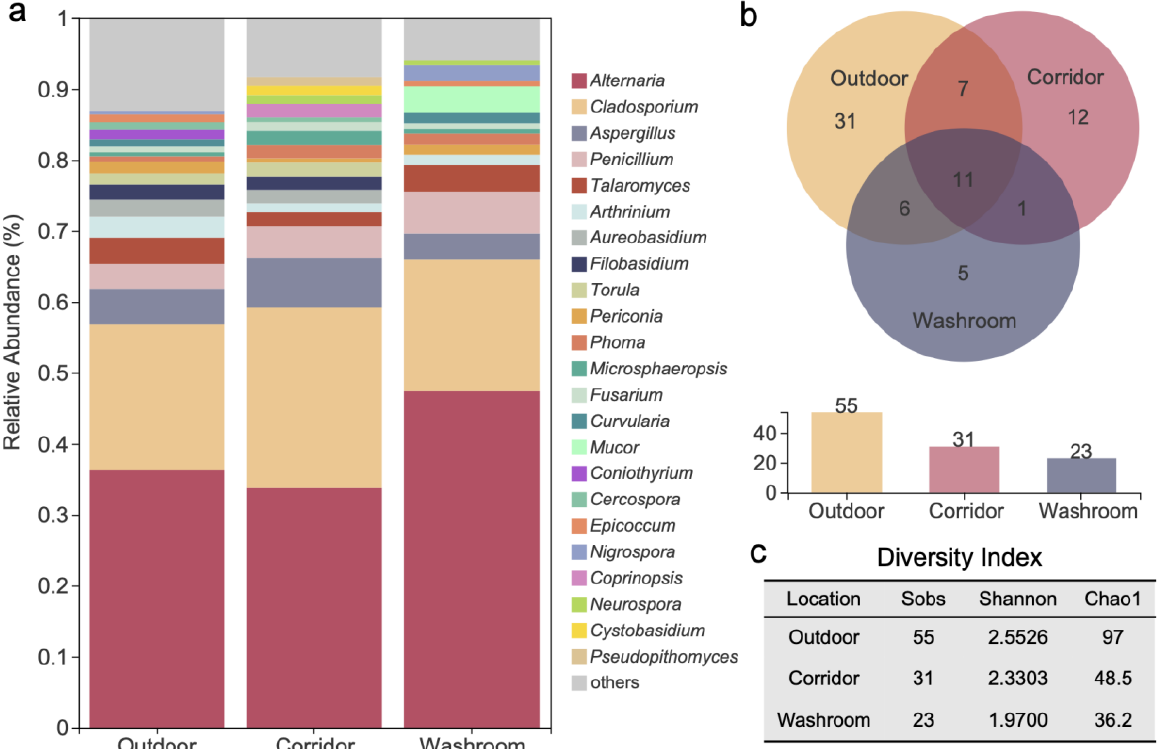
Figure 8. Genus-level fungal diversity and distribution in three sampling locations. ( a ) Relative abundances of dominant fungal genera; ( b ) the Venn diagram displaying the distribution of shared and unique genera; ( c ) diversity indexes (Sobs, Shannon and Chao1) data of fungal communities.